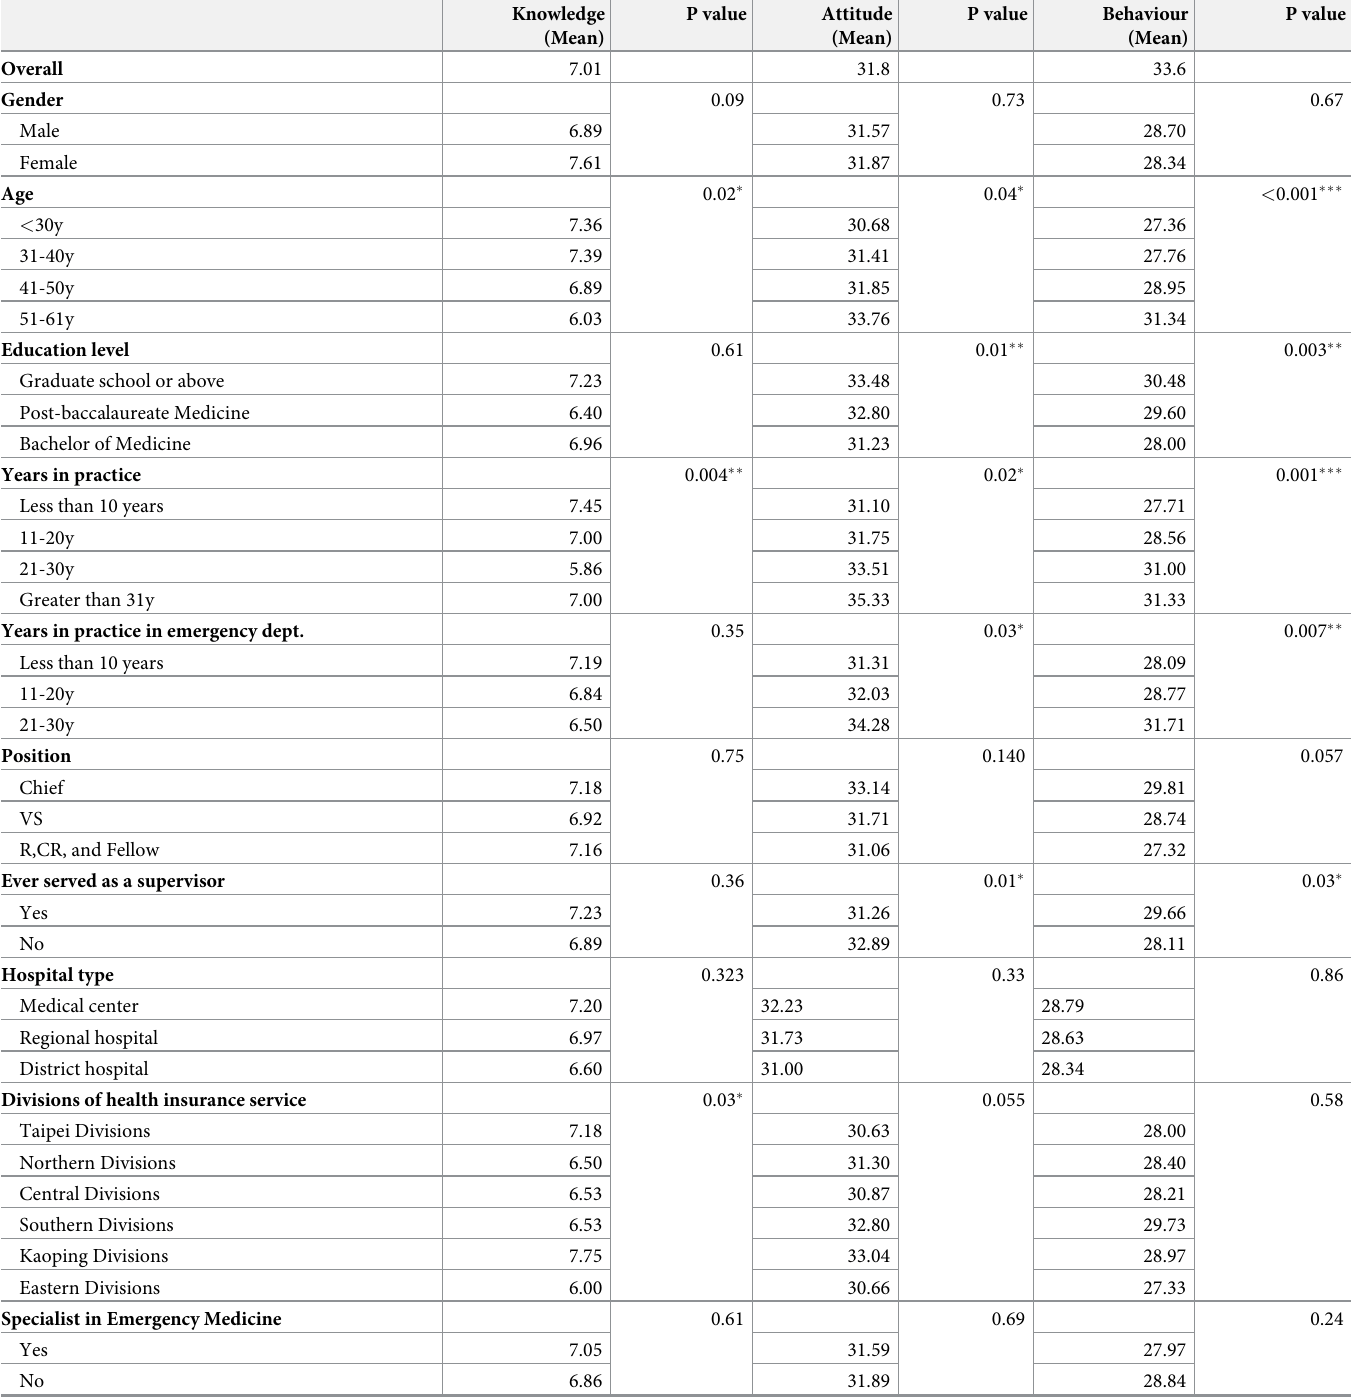
Table 3. KAB score for emergency